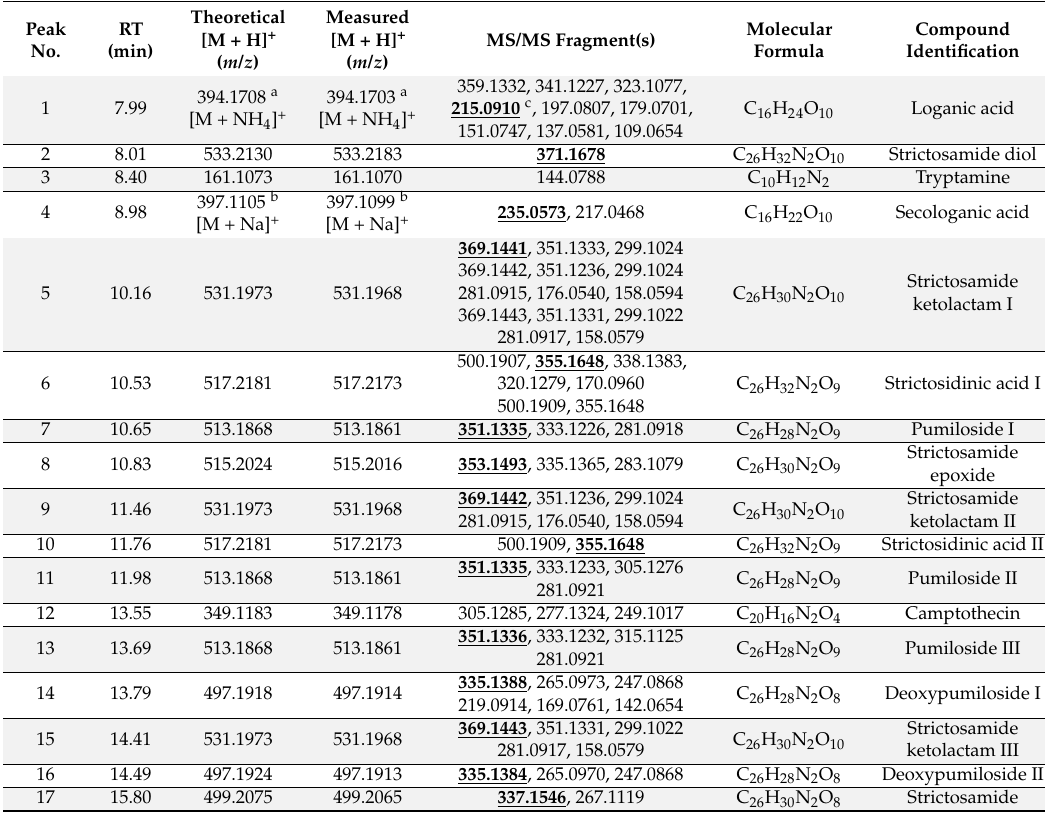
Table 2. Non-targeted analysis of the metabolic profile of intermediate compounds identified from the shoot apex of C. acuminata using HPLC-electrospray ionization (ESI) (+)-linear ion trap quadrupole (LTQ)-Orbitrap-MS/MS after MAE.